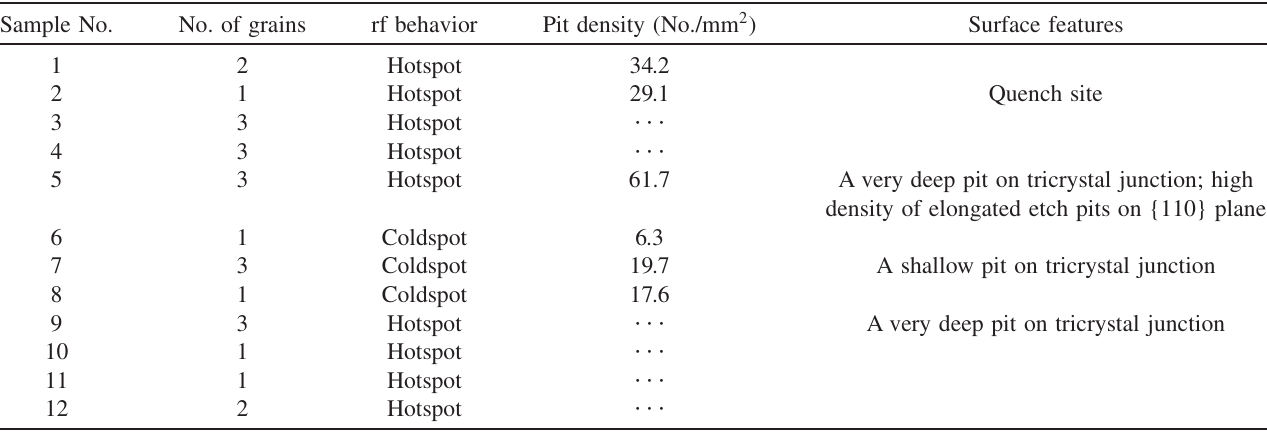
TABLE I. Summary of surface features and density of etch pits found on samples dissected from a large-grain single-cell cavity. Sample